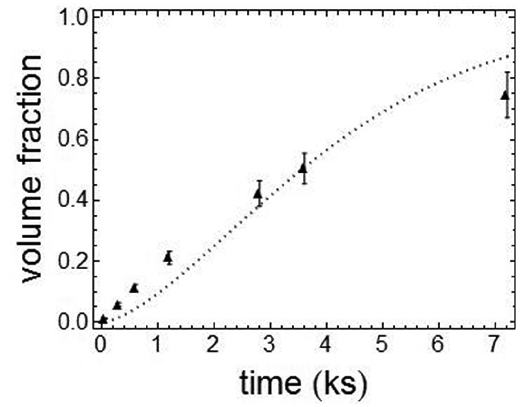
Figure 3. Comparison between model (dotted line), Equation 5, and theoretical volume fraction (filled triangles) obtained from experimental data of other orientations by Equation 2.